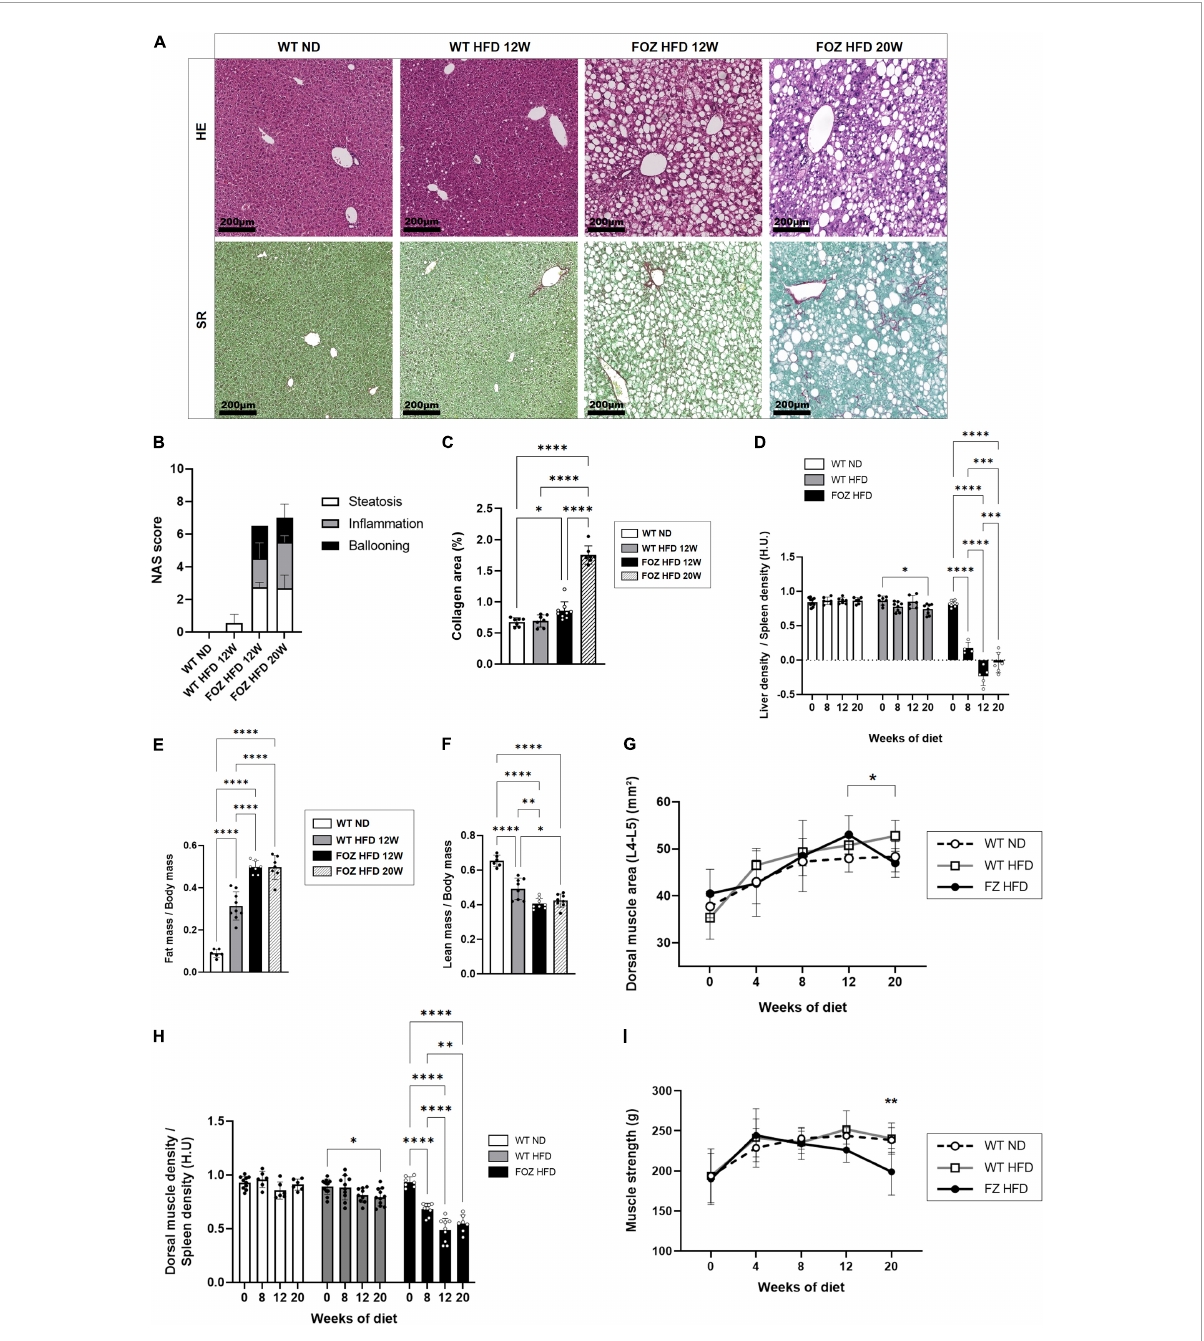
FIGURE1 NASH is associated with skeletal muscle alterations. (A) Representative hematoxylin-eosin (H&E) and Sirius red (SR) staining of liver sections from wild-type normal diet (WT ND), WT high-fat fed (WT HFD), and HFD-fed fat Aussie (FOZ HFD) mice after 12 and 20 weeks of diet; (B) Non-alcoholic fatty liver disease activity score (NAS) ( n = 4–9); (C) Collagen area assessed by digital analysis in the liver of WT ND, WT HFD and FOZ HFD after 12 and 20 weeks of HFD ( n = 7–9); (D) Liver-to-spleen density measured in vivo by micro-CT in WT ND, WT HFD, and FOZ HFD after 0, 8, 12, and 20 weeks of diet ( n = 4–10); (E) Fat mass and (F) fat-free mass (i.e., lean body mass including muscles and organs, bones excluded) measured in vivo by micro-CT ( n = 6–9); (G) Dorsal muscle area (L4–L5 averaged) in WT ND, WT HFD, and FOZ HFD between 0 and 20 weeks of diet ( n = 6–10). The ∗ represents the significant difference between 12 W and 20 W in FOZ HFD; (H) Dorsal muscle-to-spleen density measured in vivo by micro-CT in WT ND and FOZ HFD ( n = 6–10); (I) 4-limbs grip strength measured in WT ND, WT HFD, and FOZ HFD between 0 and 20 weeks of diet ( n = 8–18). The ** represents the significant difference between FOZ HFD and the two other groups at 20 W. All data are represented as mean ± SD, ∗ p < 0.05, ∗∗ p < 0.01, ∗∗∗ p < 0.001, ∗∗∗∗ p < 0.0001. Statistical tests used: (B,C,E,F) one-way ANOVA and (D,G,H,I) two-way ANOVA followed by post hoc Bonferroni